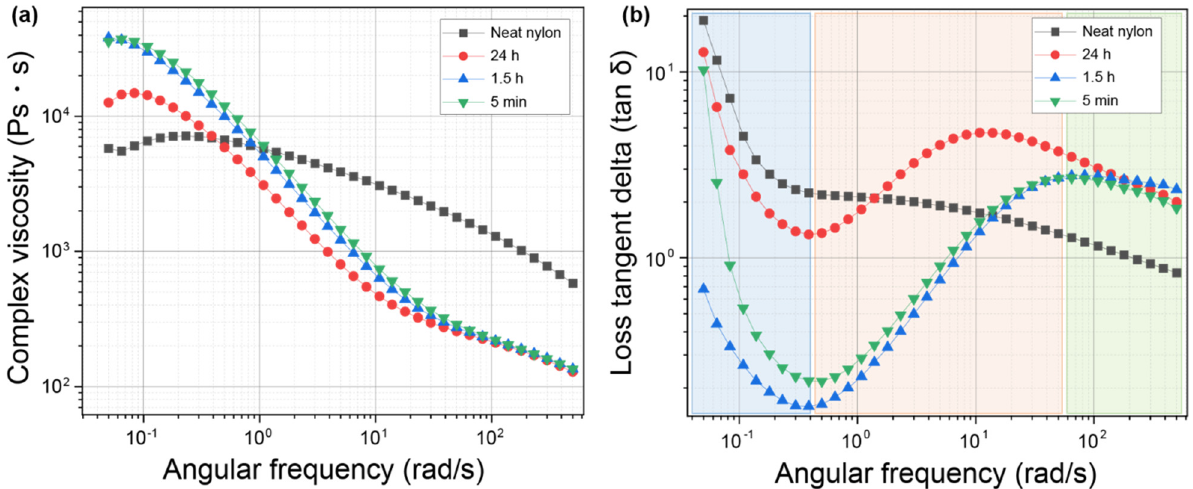
Figure 6. Rheological properties of nylon stirred with formic acid for different lengths of time to form a nylon/CSW nanocomposite. ( a ) Complex viscosities and ( b ) loss tangent delta (tan δ ) of nylon and nylon/CSW nanocomposite subjected to different acid exposure times calculated using frequency sweep experiments.